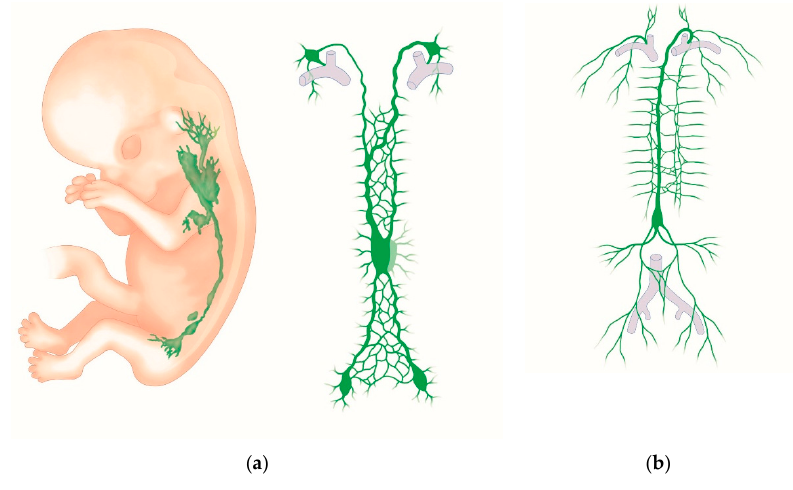
Figure 4. ( a ) Embryological development of the lymphatic system. Extreme left: schematic lateral view of an embryo in the eighth week of gestation, with three primitive lymph sacs. Middle: the lymphatic vessel system from the ventral aspect in a nine-week-old fetus, showing the pairwise thoracic duct. ( b ) Schematic illustration of the adult lymphatic system. The final thoracic duct and the right-sided lymphatic duct are also seen from the ventral aspect.